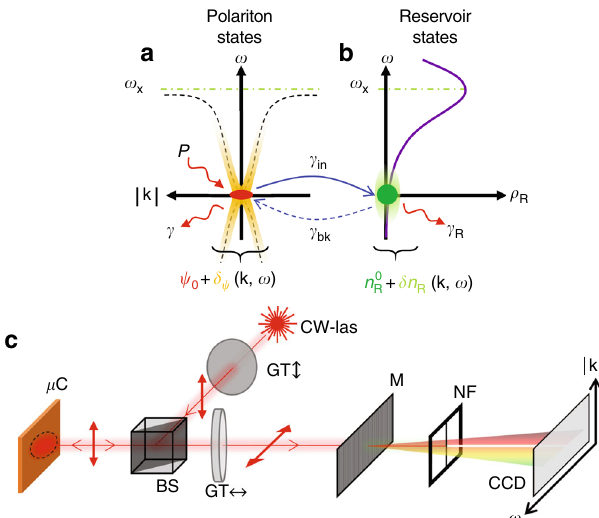
Fig. 1 Illustration of the different fl uid components and of the detection scheme. a The polariton condensate (red spot) of wavefunction ψ , and of 0 radiative loss rate γ is resonantly excited by the laser of power P. An c illustration of the condensate excitations δψ ð k ; ω Þ is shown in yellow in the dispersion plane, with its typical dispersion relation (DR) ω ðj k jÞ shown in a black dashed line. The bare quantum well excitonic transition energy _ ω is X shown as a green dashed line. An illustration of the typical quantum well ð ω Þ is shown as a purple line in b . Owing to excitonic density of state ρ R ’ s peak value exceeds the polaritonic their effective mass differences, ρ R ð ω Þ density-of-state by 5 orders of magnitude. The low-energy tail of ρ R originates from disorder in the quantum well, and can accommodate a reservoir (green spot) of long-lived excitons (loss rate γ , fl uctuations δ n R R represented in light green). Interconversion of polaritons into reservoir excitons and back by optical absorption or scattering, occur at rates γ and i n γ , respectively. c Sketch of the experimental setup used to measure the b k DR. The excitation laser light is linearly polarized by a Glan – Thompson polarizer (GT) and passed through a beam splitter (BS) to excite resonantly the polariton fl uid. The cross-polarized re fl ected signal is selected by another GT and passed through a monochromator (M). The polariton emission at the laser frequency is further rejected by a metallic fi lter playing the role of notch fi lter (NF), and the remaining EPL is detected on a CCD camera. Some optical elements are omitted, that provide resolution on the EPL emission angle θ , and thus on its in-plane wavevector j k j ¼ ð ω = c Þ sin ð θ Þ ( _ ω is the photon energy, and c the speed of light in band notch fi lter (labeled “ NF ” in Fig. 1c) made up of a featureless metallic stripe placed in the output focal plane of the monochromator. The resulting rejection is such that the EPL signal can be well identi fi ed even as close as 0.1 meV from the condensate. Figure 2c – e shows measured angle-resolved EPL ð θ ; ω Þ obtained with this method. patterns I e